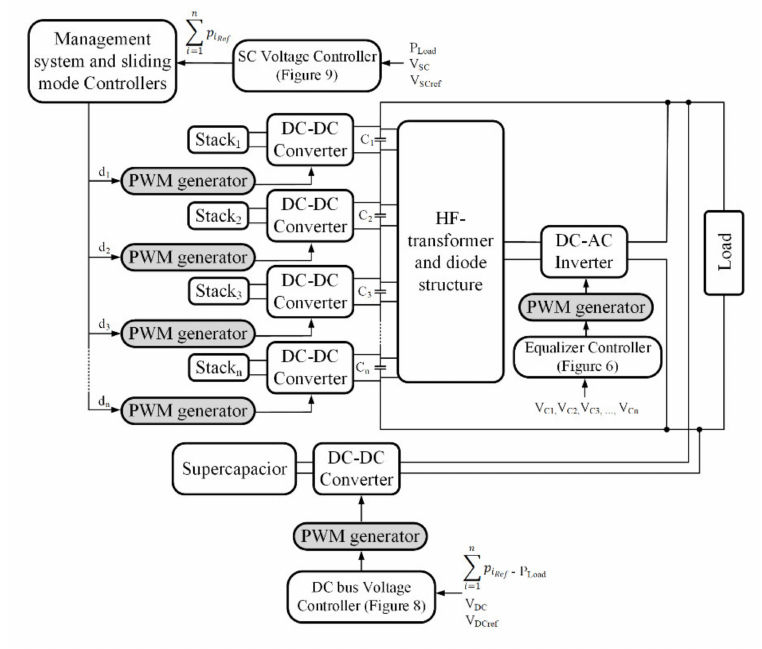
Figure 7. Diagram of the overall control